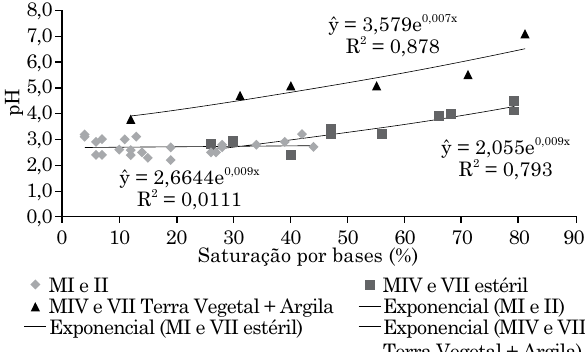
Figura 3. relação entre pH e saturação por bases das áreas I, II, IV e VII. Áreas I e II: